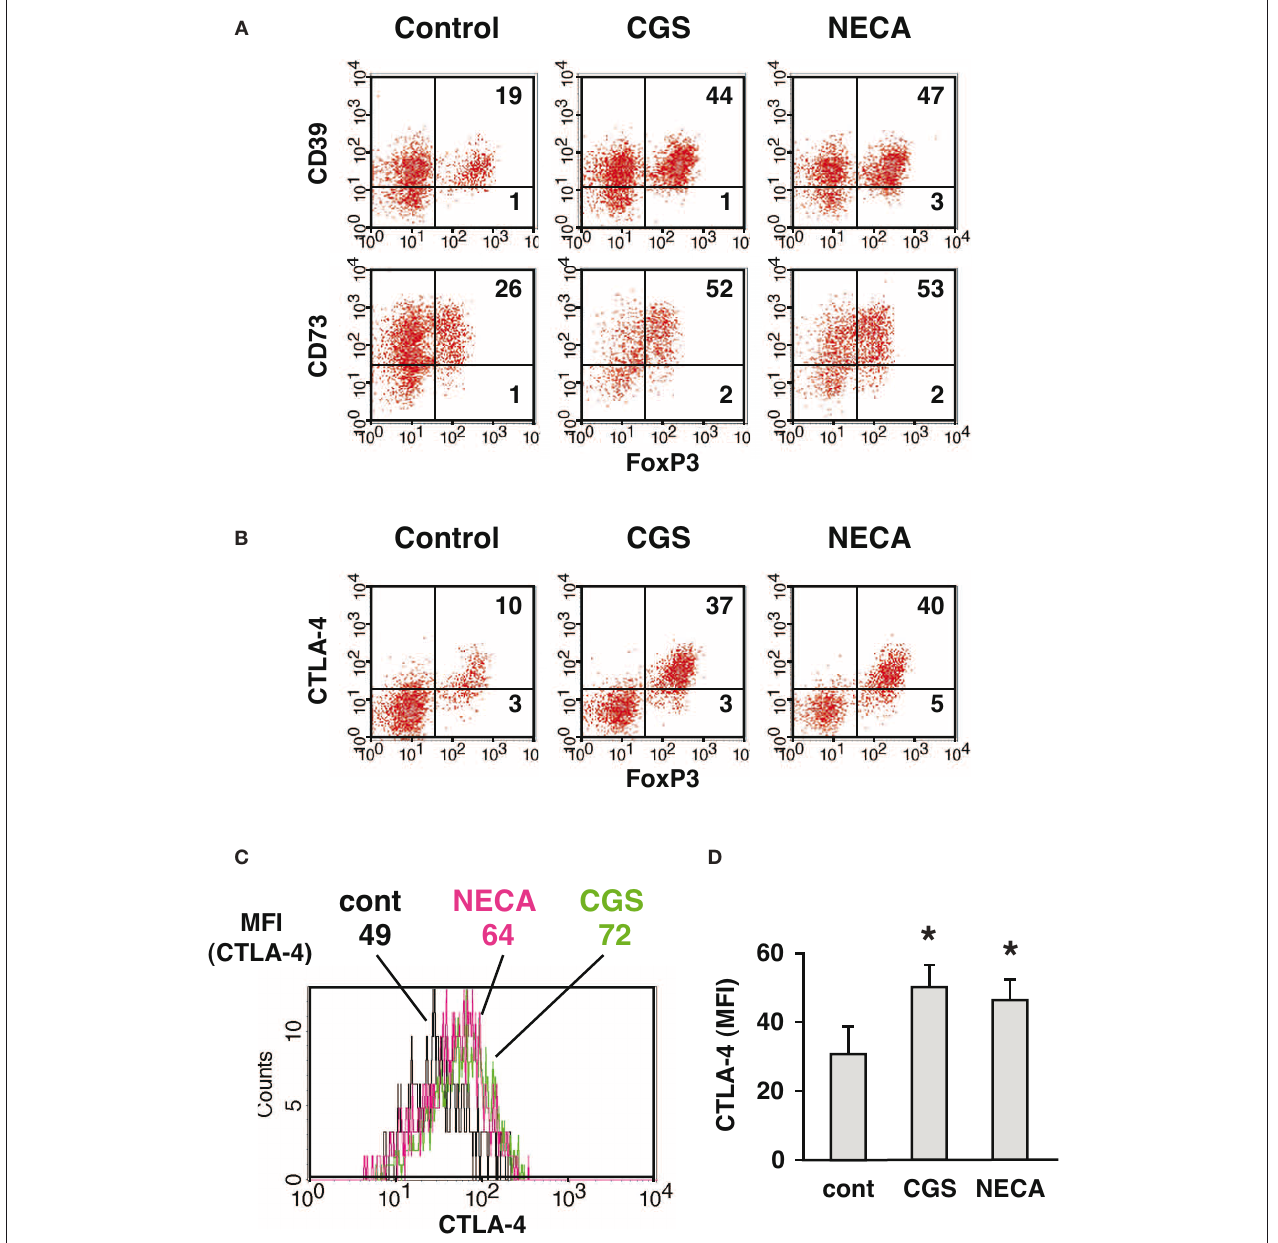
quadrant. (C) Histogram plots of CTLA-4 intensity in CD4 + FoxP3 + cells. Numbers represent mean fluorescence intensity (MFI) of CTLA-4. The data shown here represent five separate experiments with similar results. (D) Statistically significant increase of CTLA-4 levels by treatment with A2AR agonists. Data represent average ± SD of five separate experiments. ∗ P < 0 . 05 vs. control